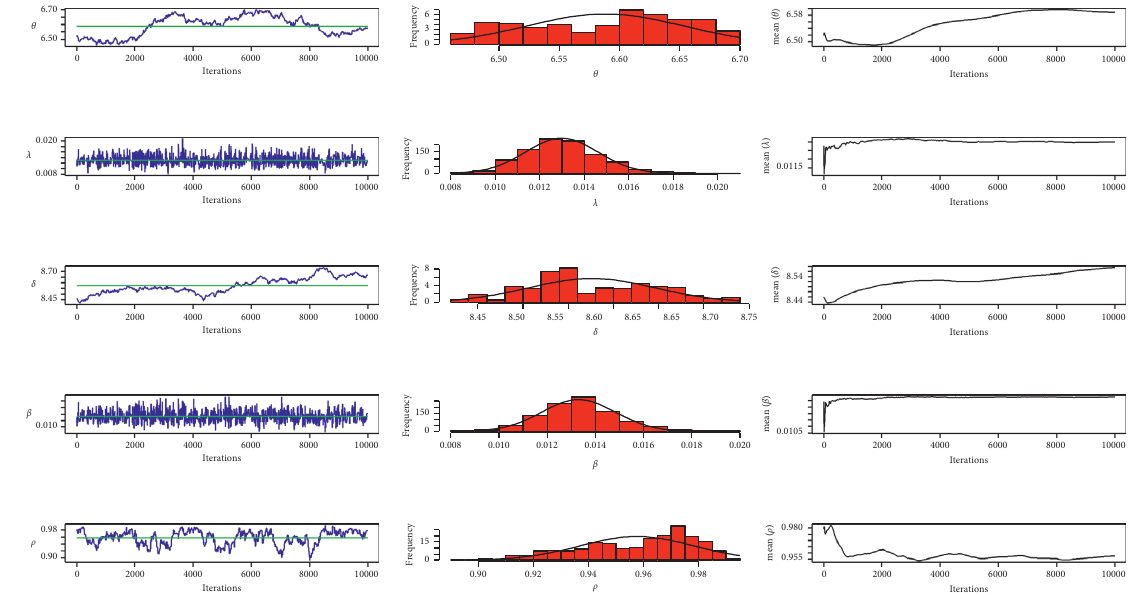
Figure 5: The Markov Chain Monte Carlo (MCMC) plots for motor data using the BMEE